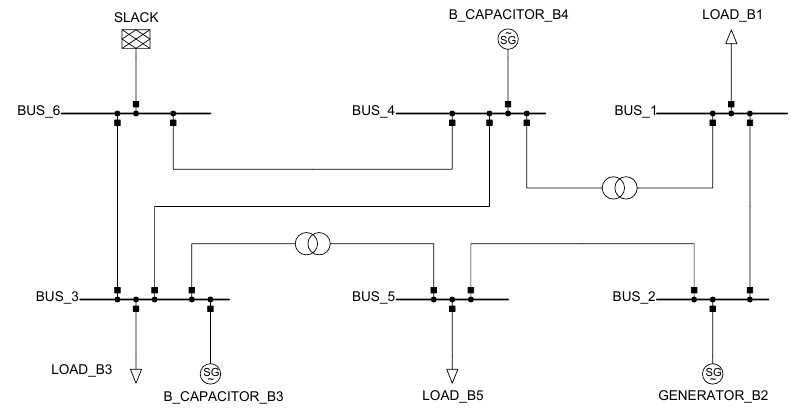
Figure 7. IEEE 6-bus test system